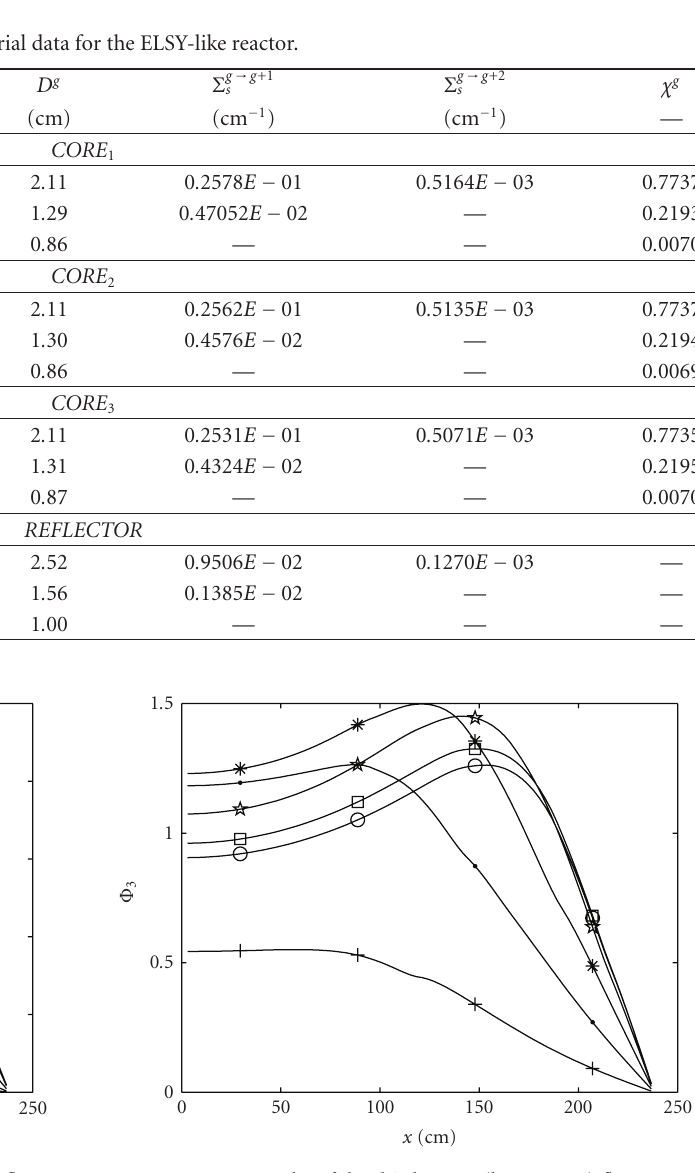
Figure 5: Graphs of the second group (intermediate energy) fluxes. Figure 6: Graphs of the third group (low energy)